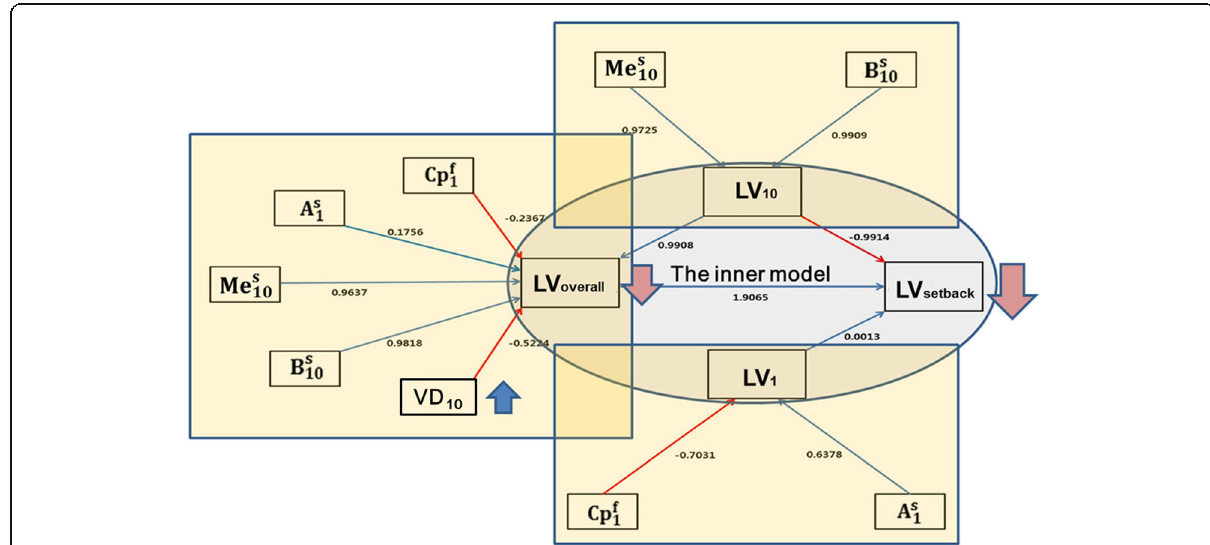
Fig. 2 Outer and inner models derived via partial-least-square path modeling (PLS-PM). The three larger rectangles represent the outer models, wherein the latent variables (LVs) LV overall , LV 10 , and LV 1 are formed by their corresponding manifest variables (MVs), represented by the smaller rectangles . The ovoid in the middle represents the quantitative interrelationship between LVs representing the inner model. The vertical arrows indicate the effect of VD on the LV setback or on the amount of mandibular setback (i.e., the absolute value of the final setback of B point), indicating that an increase in VD 10 ( blue arrow ) results in a decrease in the final mandibular setback amount measured at T 2 ( red arrow ), observed as a more severe relapse